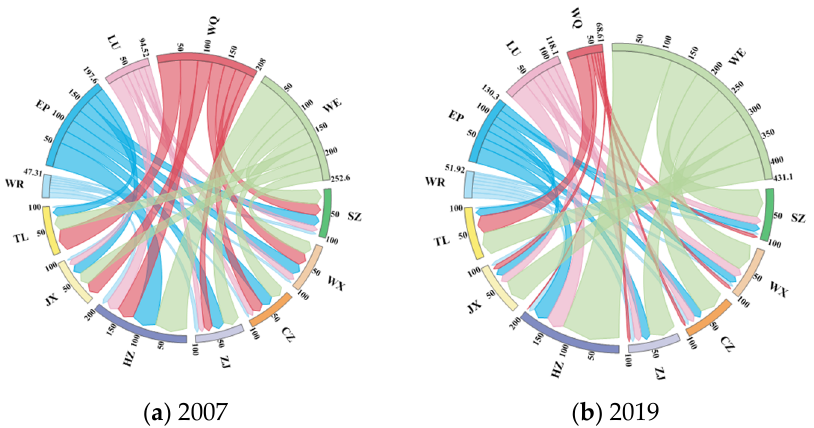
Figure 7. Obstacle factor barriers of subsystems of the regional WECC in ( a ) 2007 and ( b ) 2019.